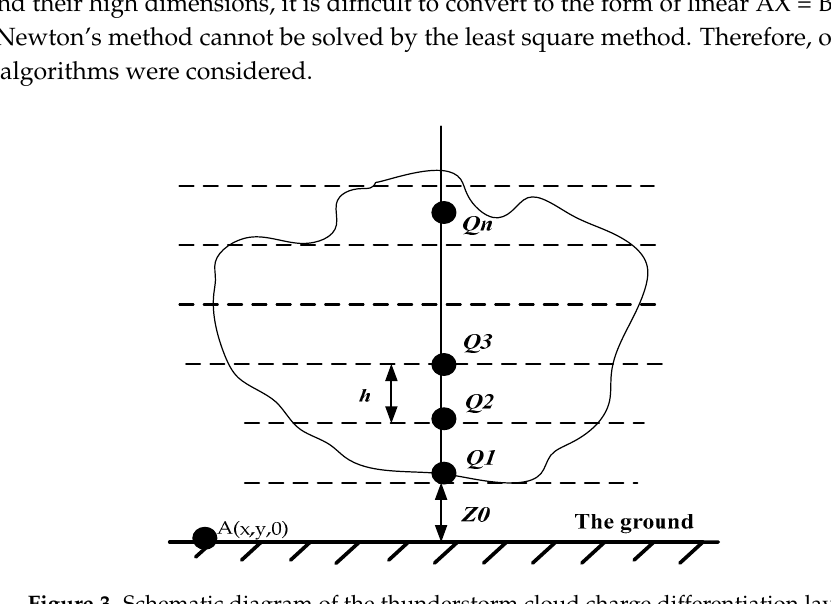
Figure 3. Schematic diagram of the thunderstorm cloud charge differentiation layer.